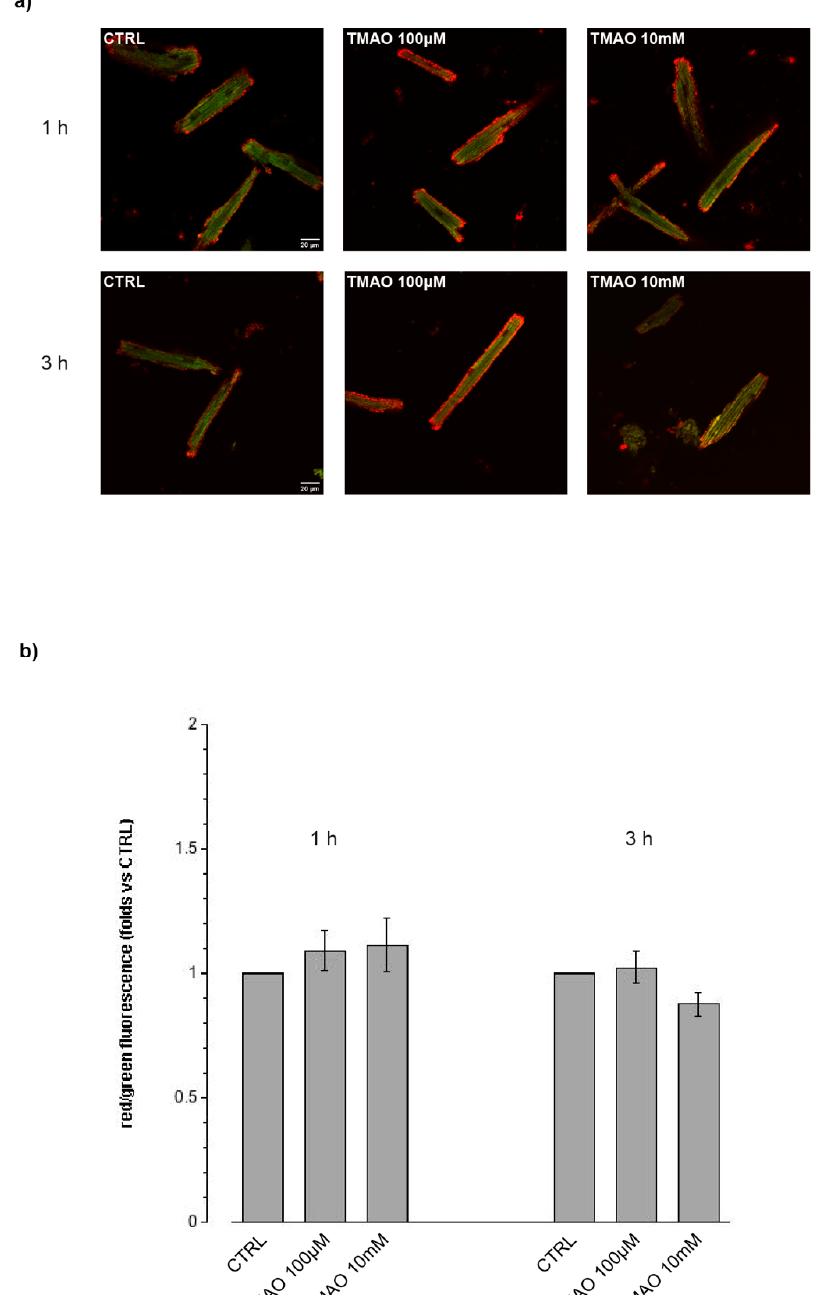
(Figure 6) (1 h—TMAO 100 µM: 1.09 ± 0.08, n = 5, 65 cells; TMAO 10 mM: 1.11 ± 0.11, n = 3, 49 cells, vs. CTRL. 3 h—TMAO 100 µM: 1.02 ± 0.06, n = 3, 26 cells; TMAO 10 mM: 0.88 ± 0.05, n = 4, 39 cells, vs. CTRL; 24 h—TMAO 100 µM: 1.08 ± 0.11, n = 3, 21 cells; TMAO 10 mM: 0.95 ± 0.15, n = 3, 54 cells; DOX: 0.73 ± 0.02, n = 3, 24 cells (** p < 0.01) ; DOX + TMAO: 0.69 ± 0.05, n = 3, 22 cells (** p < 0.01) , vs. CTRL).